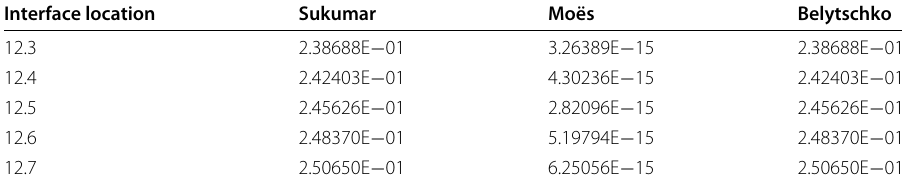
Table 6 Comparison of relative error in energy norm for different interface locations between the different enrichment functions for linear elements used in the bi-material bar problem (results obtained with E1 = 2.05 MPa, E2 = 20.5 MPa, L = 25 m and ¯ u = 3 · 10 − 6 m)